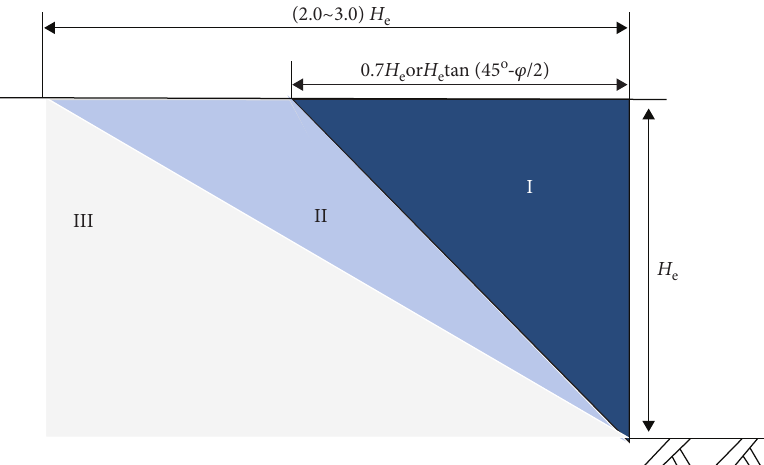
Figure 3: Impact zone of deep foundation pit